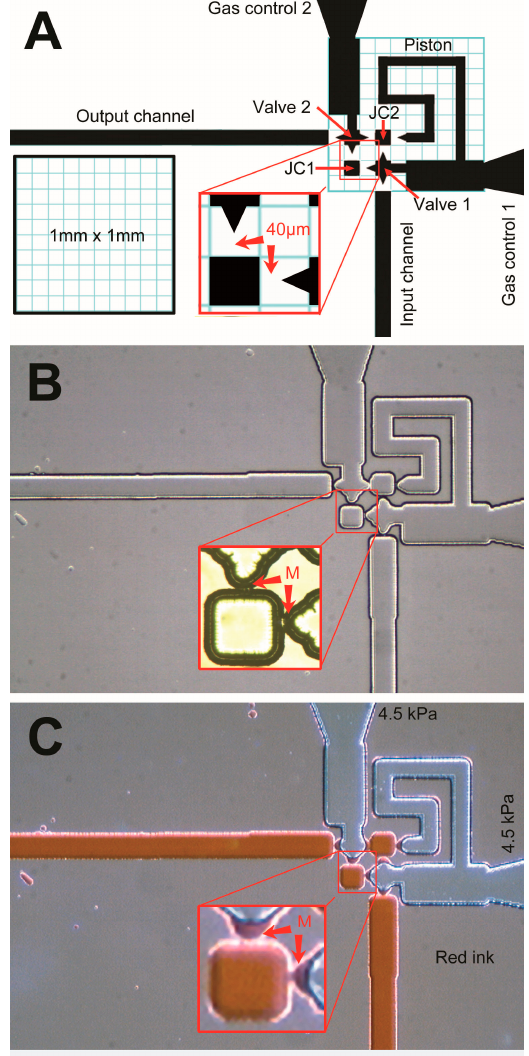
Figure 1. An actual design of a one-square millimeter MISPU and its fabrication by one-step glass etching. The black area of the photomask design ( A ) represents the etching area. The small blue grids in the one mm squares mark the size of 100 μ m. Channels, chambers and valves separated by 40 μ m gaps unite after 30- μ m glass etching ( B ). The narrow connections help the high gas pressure (4.5 kPa) to form stable gas-liquid interfaces (MISTA, labeled by the red M) to stop microfluidic flow indicated in red ink ( C ). JC1: Joint chamber 1; JC2: Joint chamber 2.